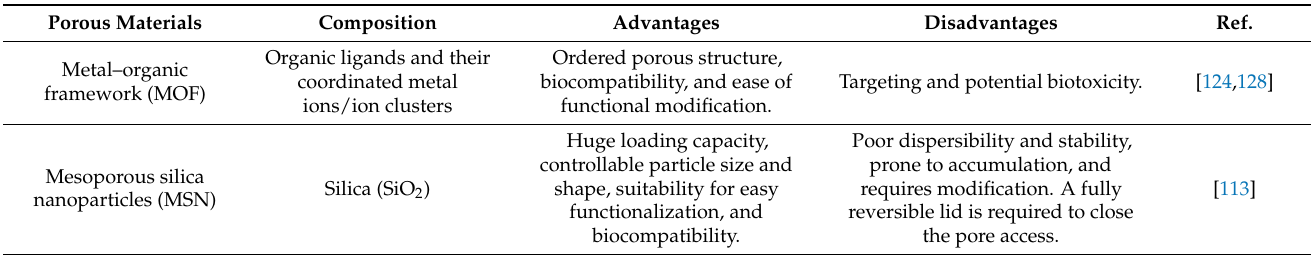
Table 2. Comparison of different porous materials or